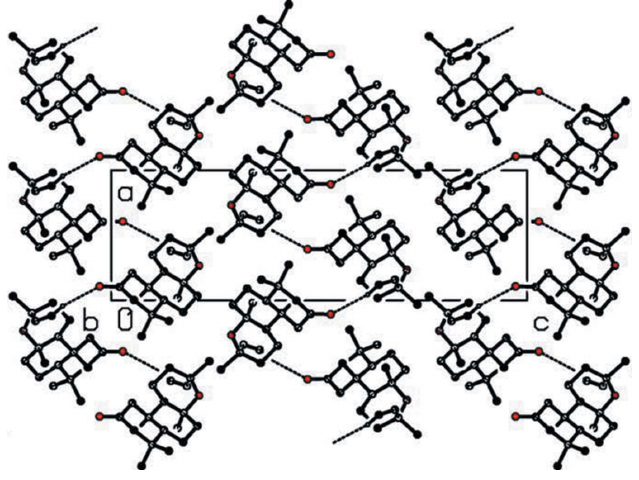
Figure 2 A view along the a axis of the crystal packing of the title compound. H atoms not involved in these interactions have been omitted for clarity.